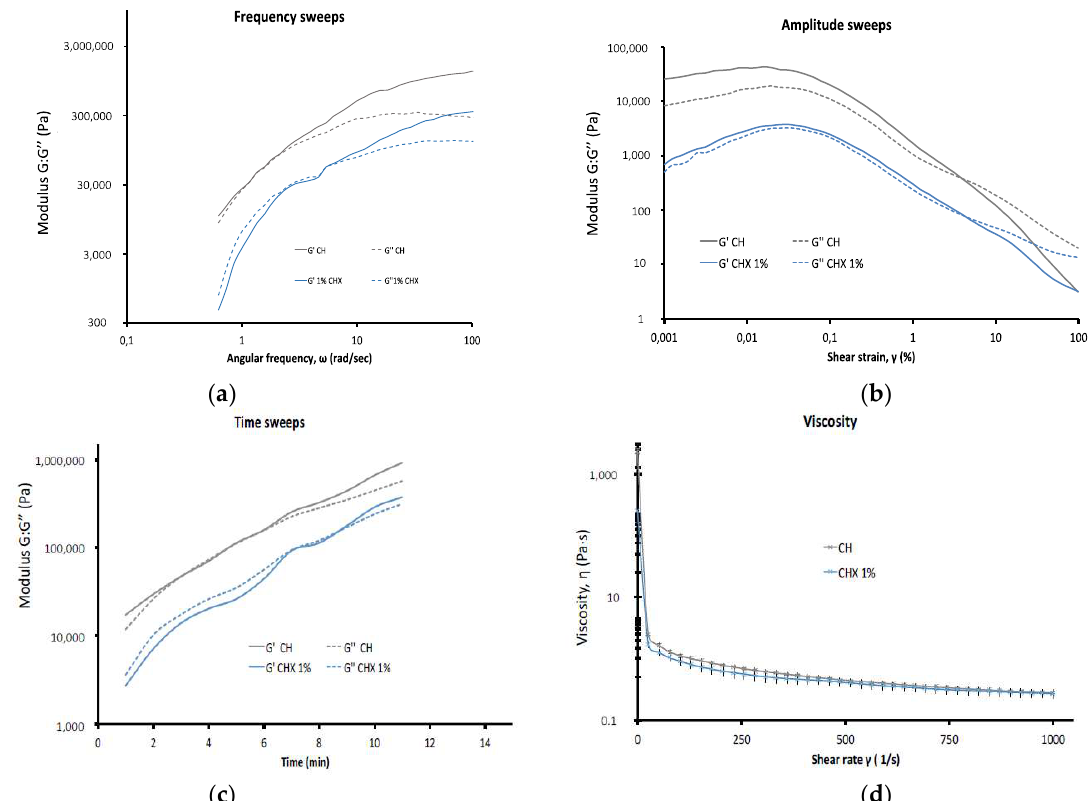
Figure 4. The rheological properties of the calcium hydroxide paste formulations: chlorhexidine-free calcium hydroxide paste (CH) and calcium hydroxide with 1% chlorhexidine (CHX) (10 × 10 3 mg/L): ( a ) frequency sweeps: determining G′ and G″ at a constant strain of 0.01%; ( b ) amplitude sweeps: determining G′ and G″ at a different shear strain; ( c ) time sweeps: evolution of the storage (G′) and loss (G″) moduli as a function of time at a frequency of 2.5 rad/s at 20 °C; ( d ) viscosity: shear-thinning evaluation by shear-rate dependent variations in viscosity.